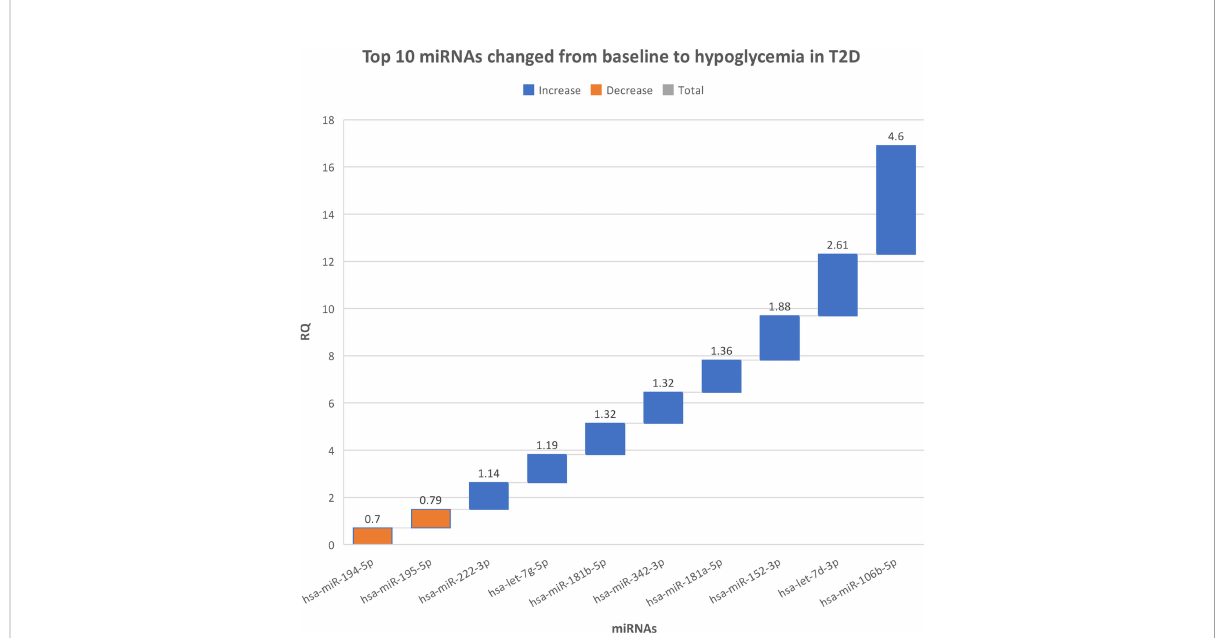
FIGURE 2 The top 10 miRNAs that changed from baseline to hypoglycemia in type 2 diabetes subjects. RQ, mean relative quanti fi cation.